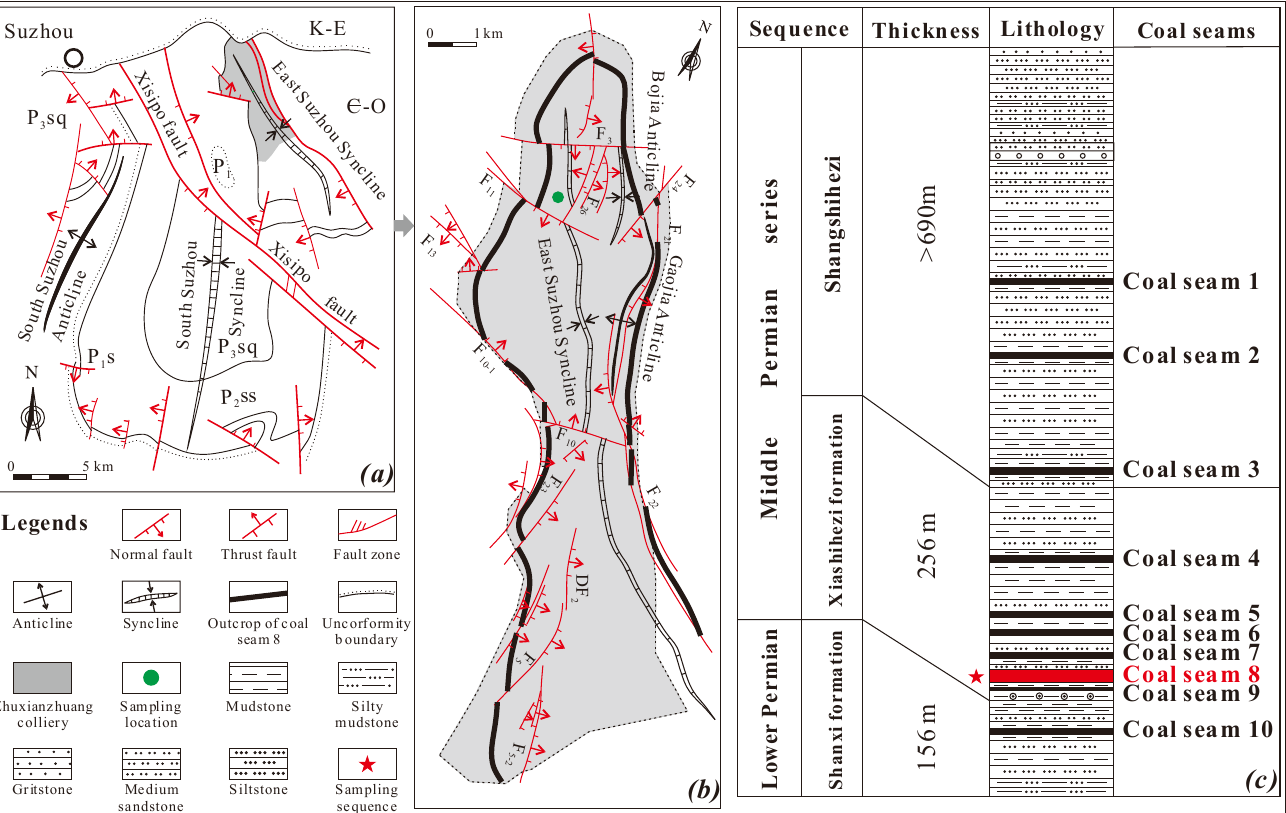
Figure 1. Distribution of sampling sites. ( a ) Structure outline of the Suxian coal mine and the location of the Zhuxianzhaung colliery. ( b ) Structure outline of the Zhuxianzhaung colliery and the location of the specific sampling site. ( c ) Detailed stratigraphic column of the coal-bearing strata in the Zhuanxianzhuang colliery (modified from Jiang et al. [1] and Liu et al. [60]).